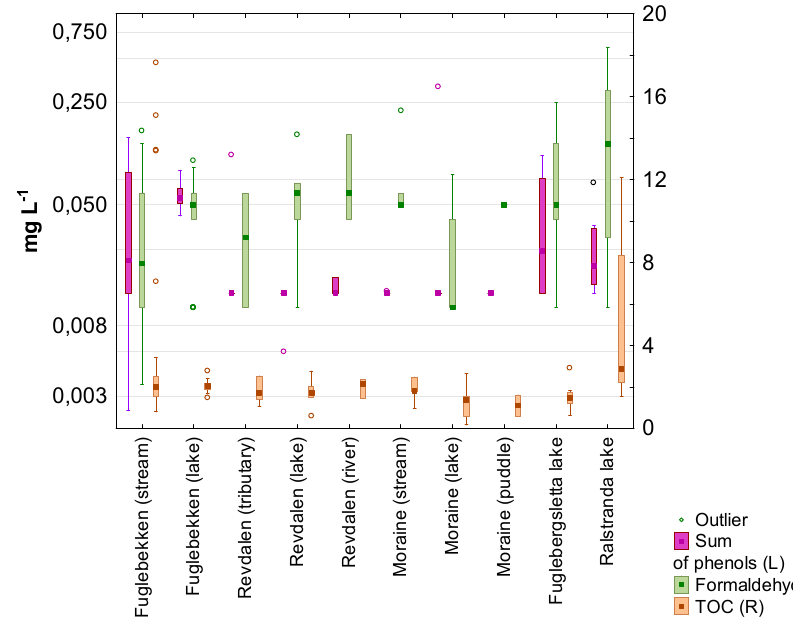
Figure 4. Formaldehyde, phenols and total organic carbon (TOC) concentrations measured in the freshwater from lakes and streams in the Hornsund area. (R) or (L) signifies which Y-axis (right or left) the particular parameter is plotted upon (left Y-axis in logarithmic scale). Box = results range from first (Q 1 ) to the third quartile (Q 3 ); filled marker inside the box = median (Q 2 ); whiskers = range of results except outliers; outlier = above Q 3 + 1.5 × (Q 3 − Q 1 ) or below Q 1 − 1.5 × (Q 3 − Q 1 ).